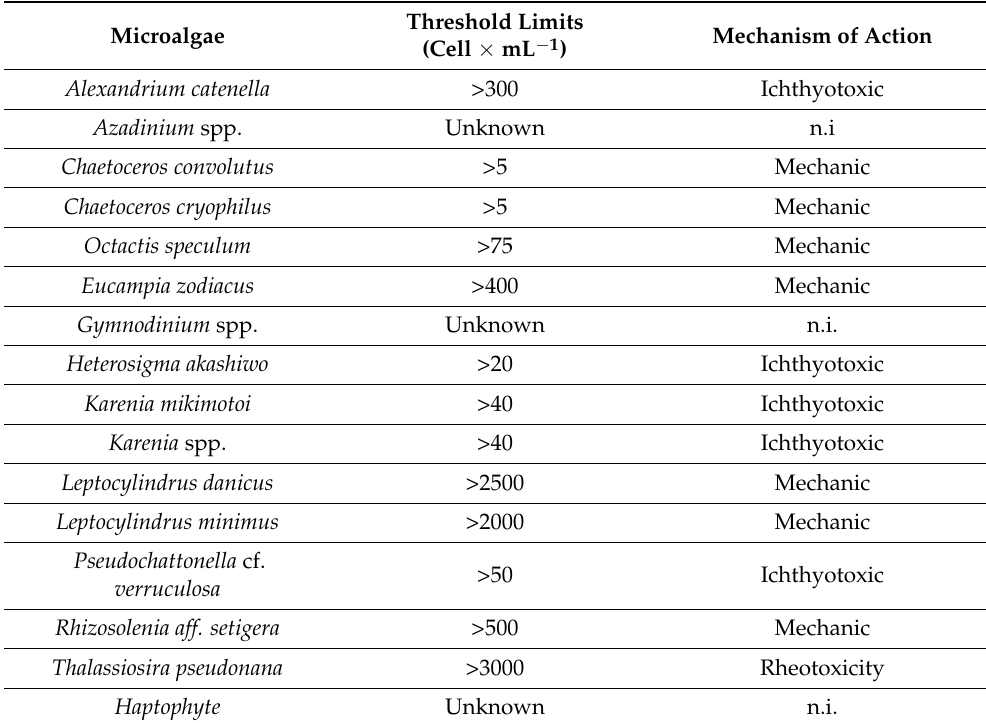
Table 2. List of harmful microalgae monitored in salmon farms in Chile and their threshold limits [45]. n.i = no